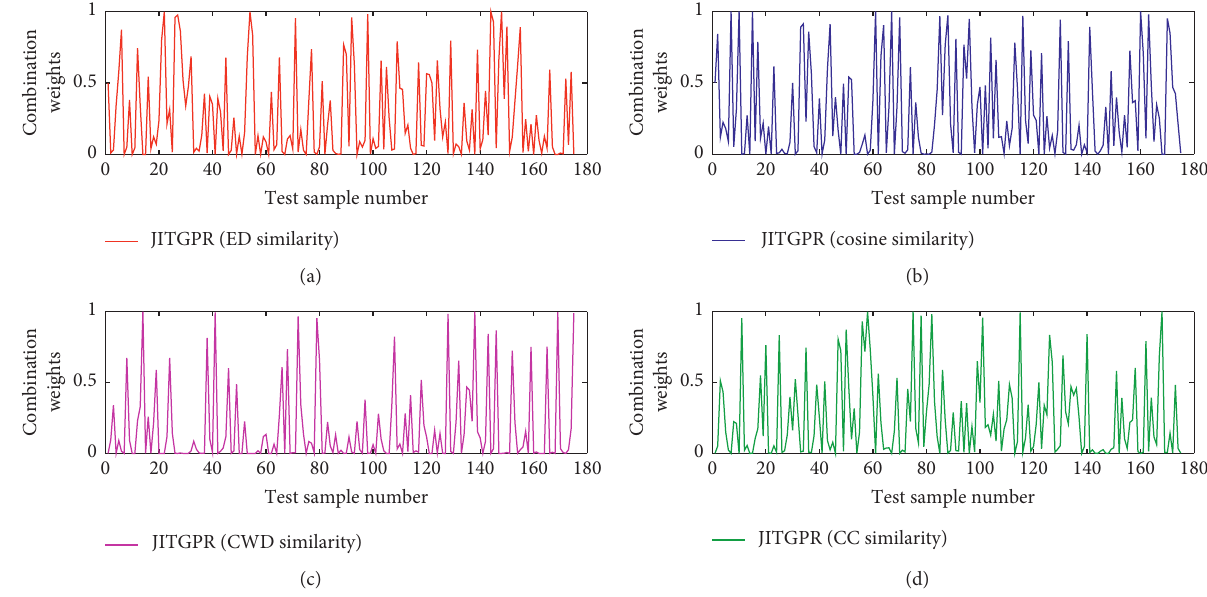
JITGPR (CWD Figure 7: Combination weights assigned to different JITGPR models in MP-EJITGPR (FMM) method. (a) JITGPR (ED similarity). (b) JITGPR (cosine similarity). (c) JITGPR (CWD similarity). (d) JITGPR (CC similarity).